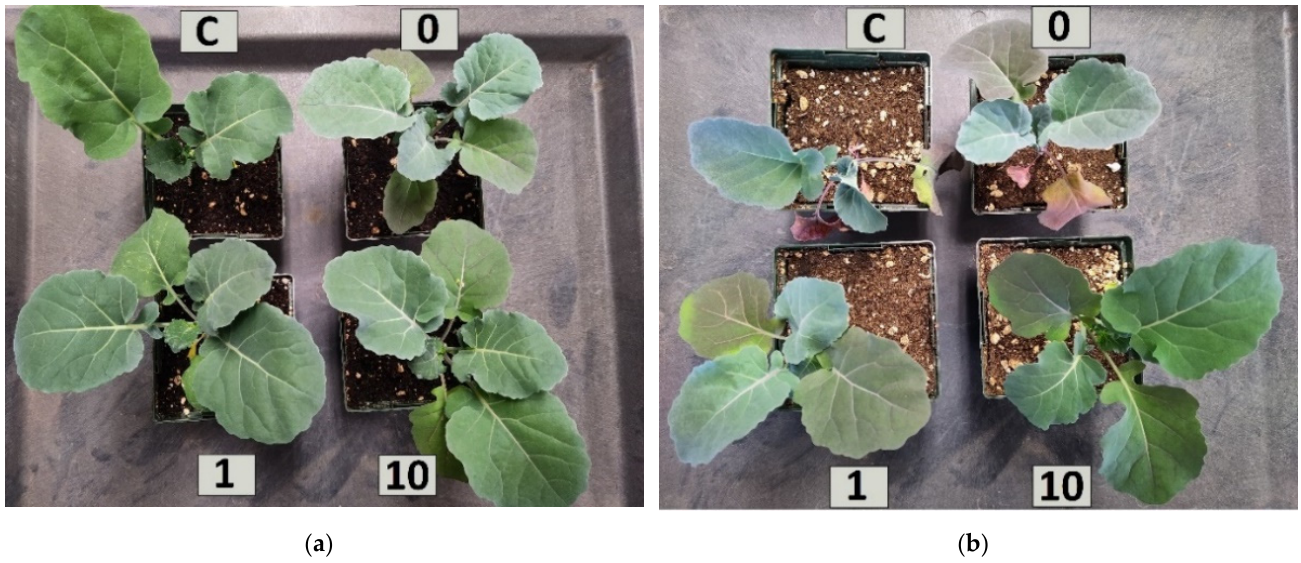
Figure 3. Overhead view of 9-week-old broccoli seedlings that were ( a ) watered and ( b ) deprived of water for 1 week. Control seedlings (C) were provided no seed preconditioning while others were provided 0 ppm, 1 ppm, or 10 ppm of ascorbic acid preconditioning.